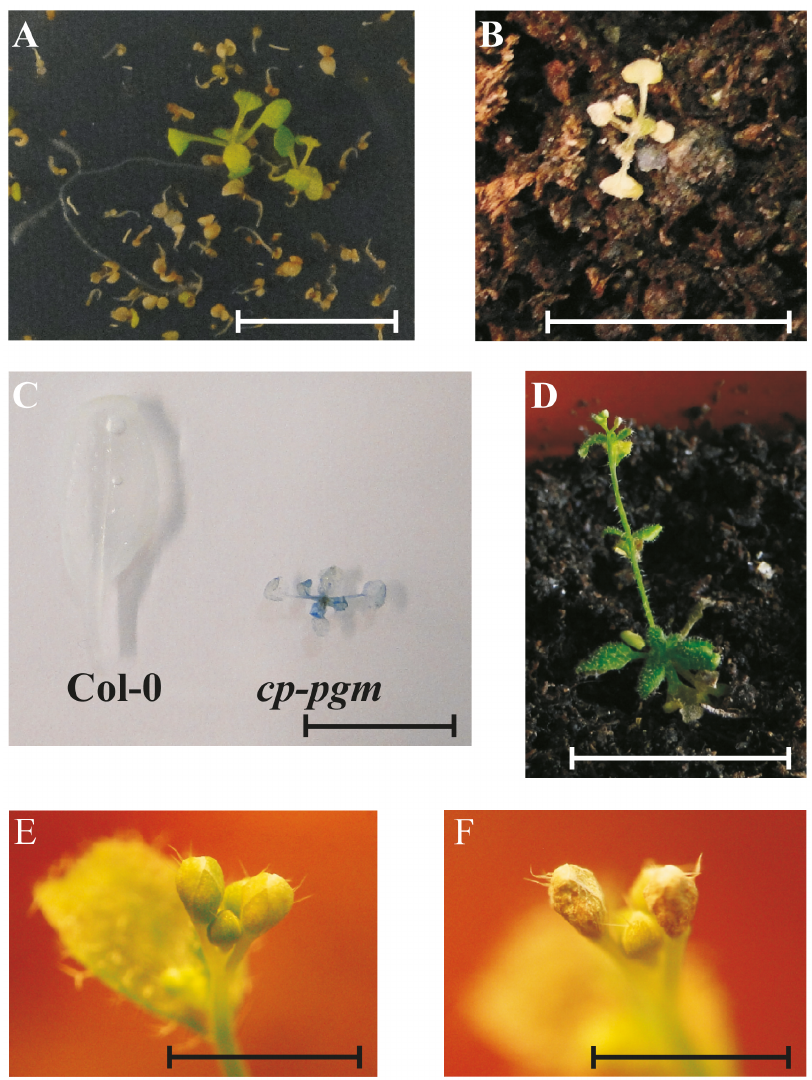
Figure 6. Growth phenotype of cp-pgm plants. A, Seeds were sowed on MS medium containing sucrose and antibiotics (kanamycin [50 m g/mL], hygromycin [50 m g/mL]). Plants were grown under long day conditions (16 h light/8 h dark) and were two-week-old. Bar=1 cm. B, cp-pgm plant before trypan blue staining. C, Col-0 and cp-pgm plants after trypan blue staining. The cp-pgm plant was five- week-old, germinated on MS plate (as above) and the two last weeks grown under continuous illumination. Leave of Col-0 from three-week-old plant grown under 12 h light/12 h dark conditions. Bars=1 cm. D–F, Phenotype of cp- pgm plants under continuous illumination. Seeds were germinated on MS medium containing sucrose with antibiotics (kanamycin [50 m g/mL], hygromycin [50 m g/mL]). After four weeks plants were transferred to soil and grown further under continuous illumination. D, Plant was six-week-old. Bar=1 cm. E–F, Flower buds of cp-pgm transgenic plants. Plant was six-week-old (E) and seven-week-old (F). Bars=1